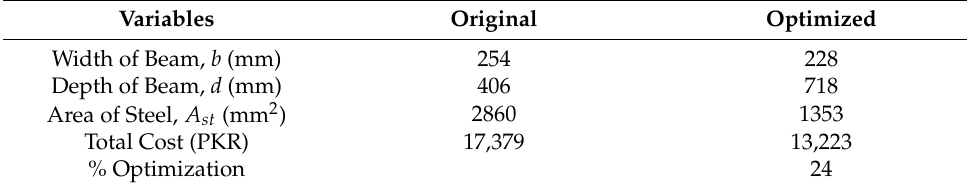
Table 4. The optimization results for Example